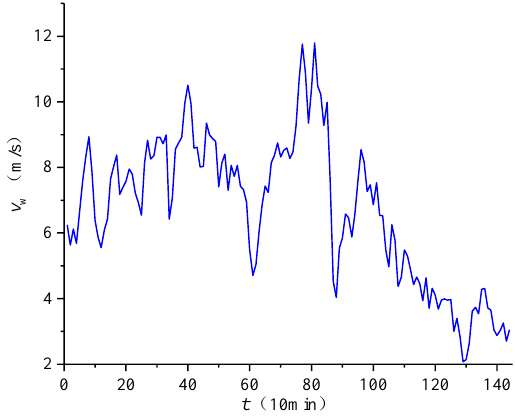
Figure 7. Sample of wind speed time series.